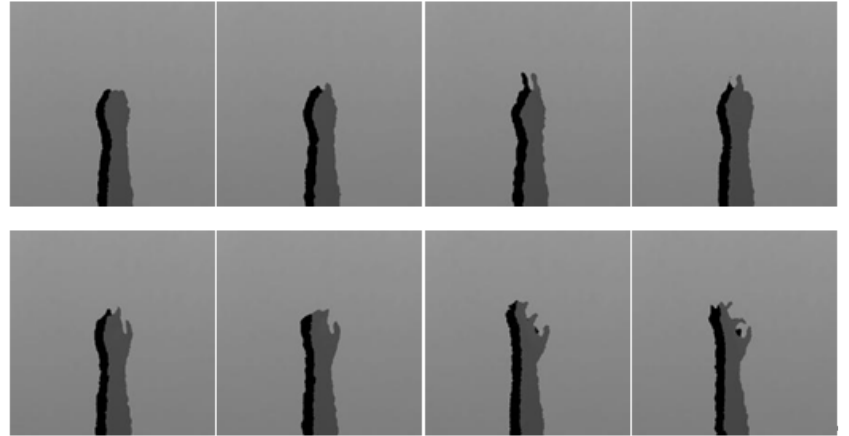
Figure 14. The sensor modality of “depth-grayscale” of the hand gesture intention action, Action 1.